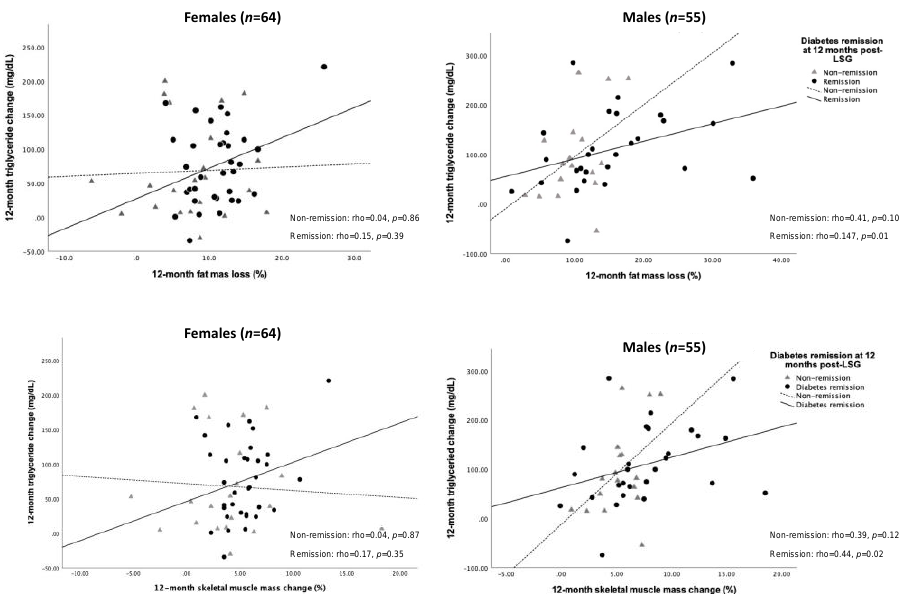
Figure 4. Spearman’s correlation of changes in FM loss, SM gain, and triglyceride over 12 months after LSG according to sex difference. Abbreviation: FM, fat mass; SM, skeletal muscle mass; LSG, laparoscopic sleeve gastrectomy.